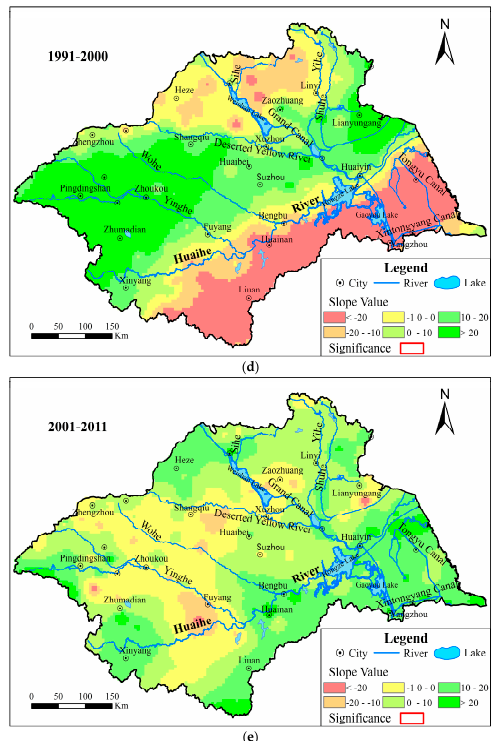
Water 2017 , 9 , 489 12 of 19